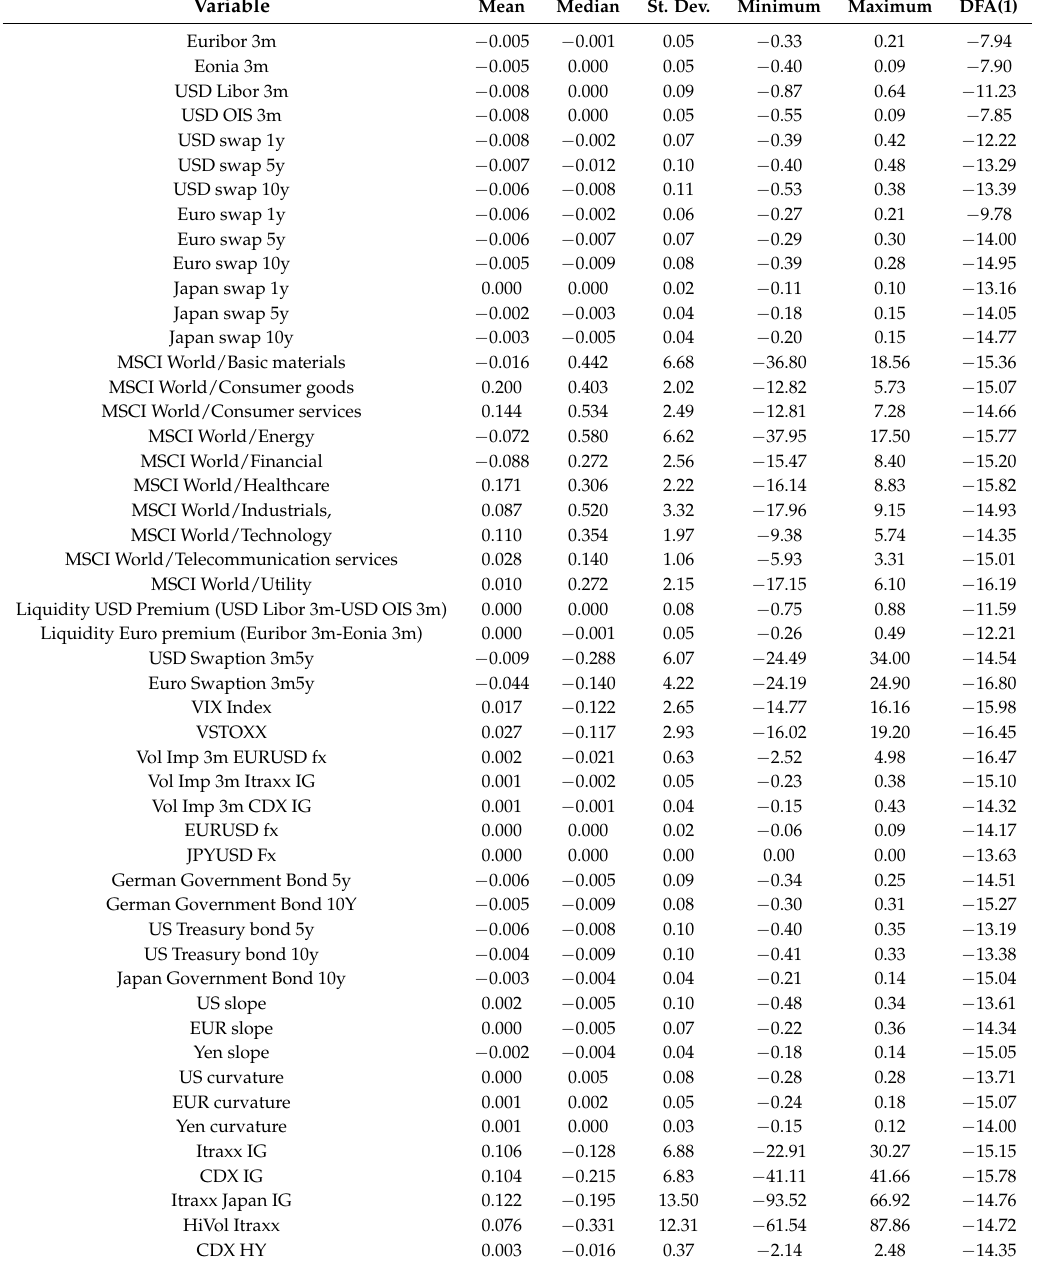
Table 2. Economic and financial indicators (in differences): main